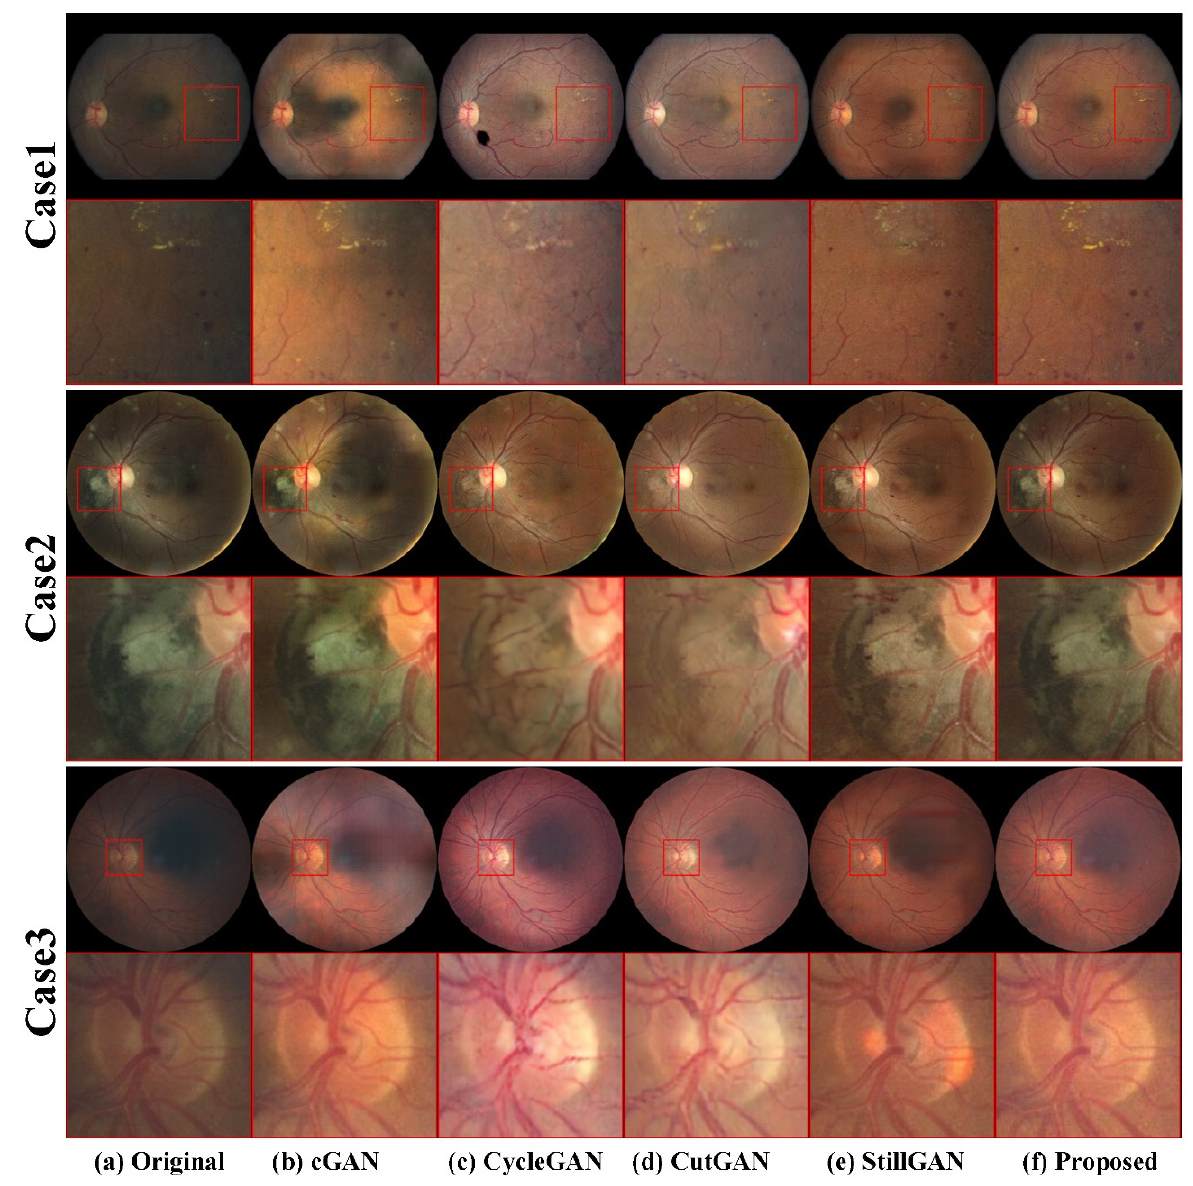
Figure 3. Visual comparisons on image enhancement task. In each case, the first row contains color fundus images enhanced by different methods, and the second row are patches cropped from red box areas in the first row.